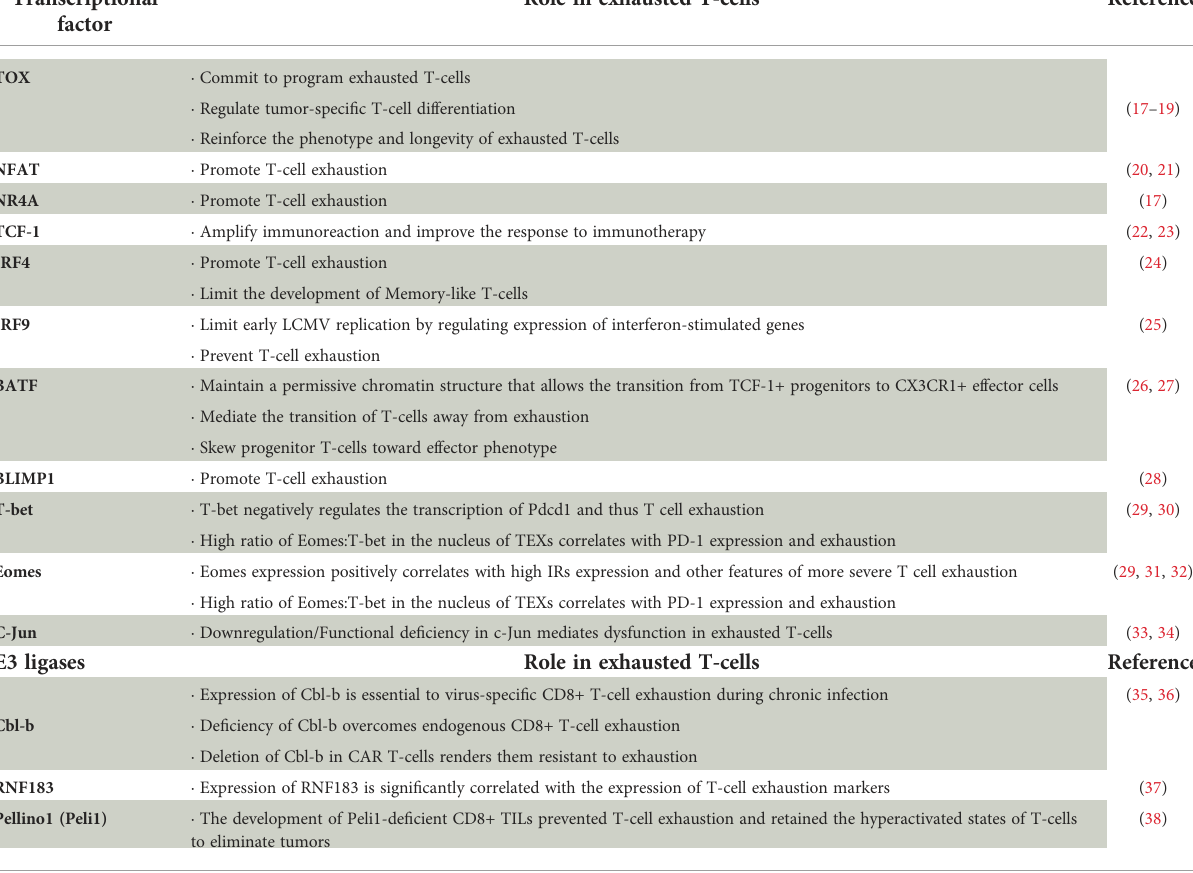
TABLE 1 Overview of transcriptional factors and E3 ligases involved in T-cell